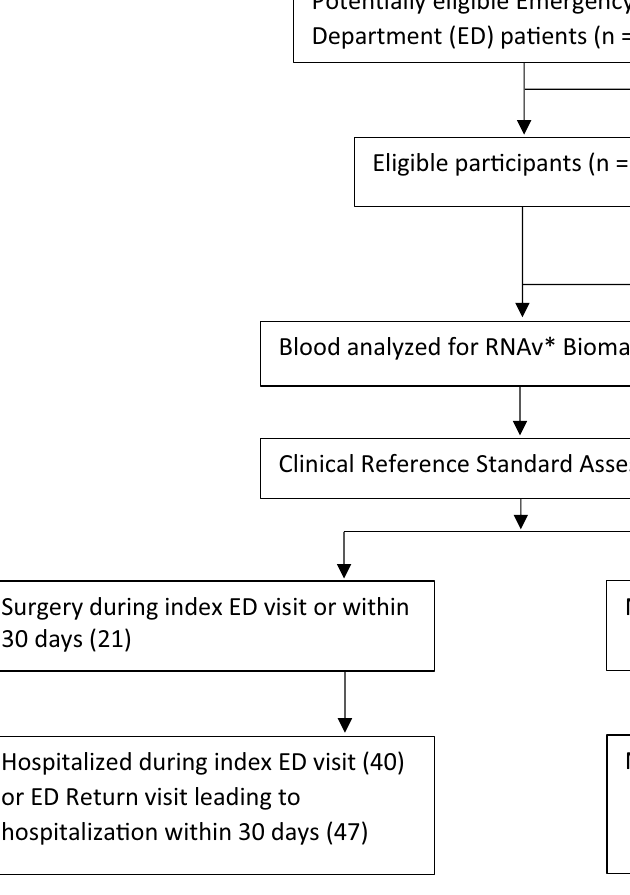
Figure 1. Overall study design. *RNAv Biomarker refers to the target biomarkers for the study: DEFA1, ALPL and IL8RB. ED Emergency